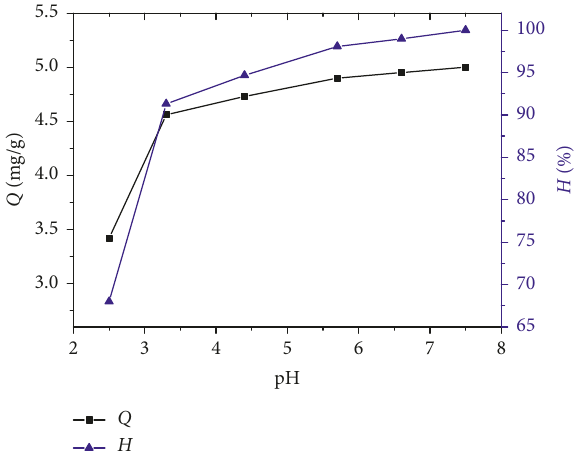
Figure 10: The effect of the pH value on the adsorption capacity and the removal efficiency of Pb 2+ ( m HApgranules 30mg/L; t contact 40min; T 30 ° C). C 0 (cid:31) (cid:31) (cid:31)